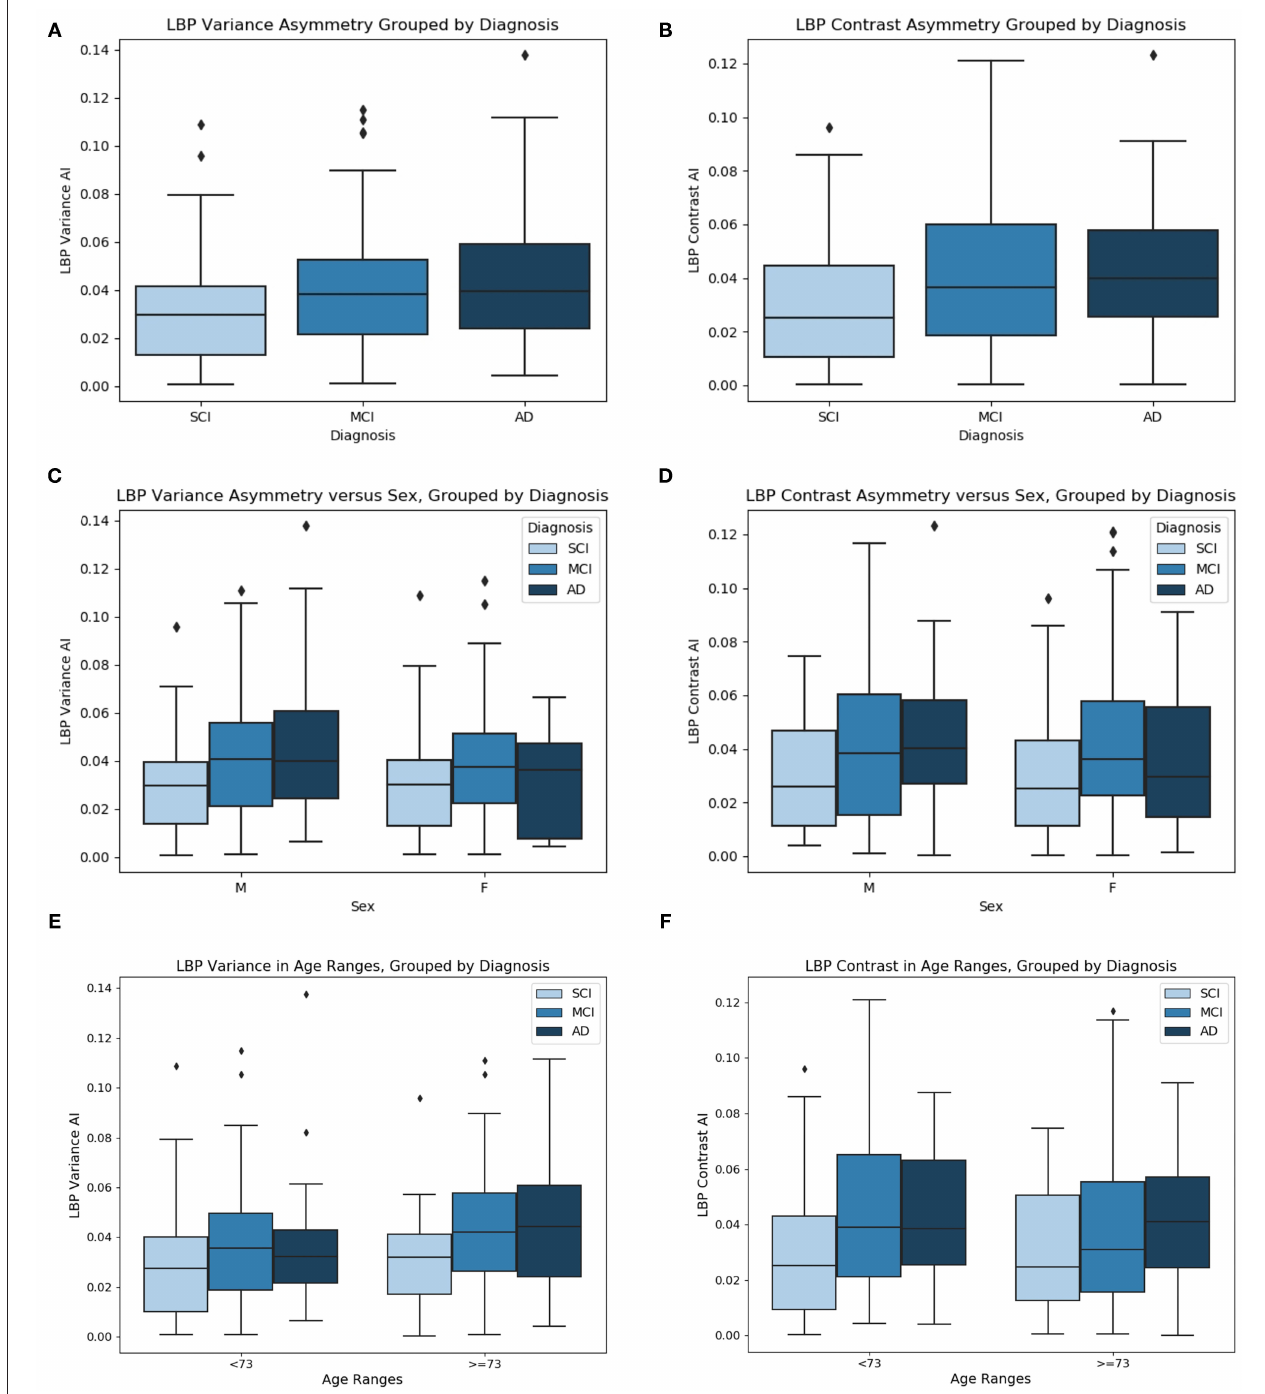
FIGURE 10 | (A) LBP variance asymmetry, (B) LBP contrast asymmetry grouped by diagnosis, (C) LBP variance asymmetry vs. sex, grouped by diagnosis, (D) LBP contrast asymmetry vs. sex, grouped by diagnosis, (E) LBP variance asymmetry vs. age grouped by diagnosis, and (F) LBP contrast asymmetry vs. age, grouped by diagnosis. Age ranges split by median